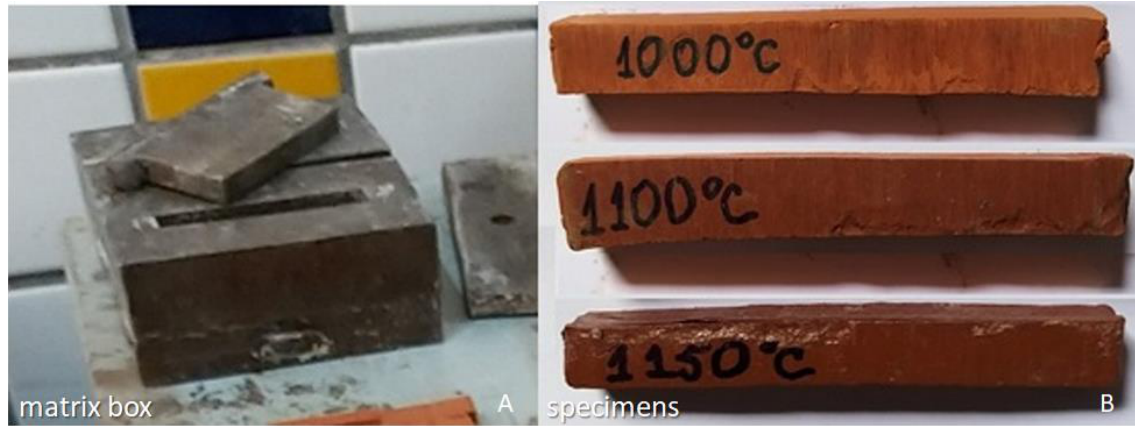
Figure 2. Matrix box for making prismatic specimens ( A ), and examples of burned specimens( B ). The firings were carried out at 800 ◦ C, 900 ◦ C, 1000 ◦ C, 1100 ◦ C, and 1150 ◦ C in a